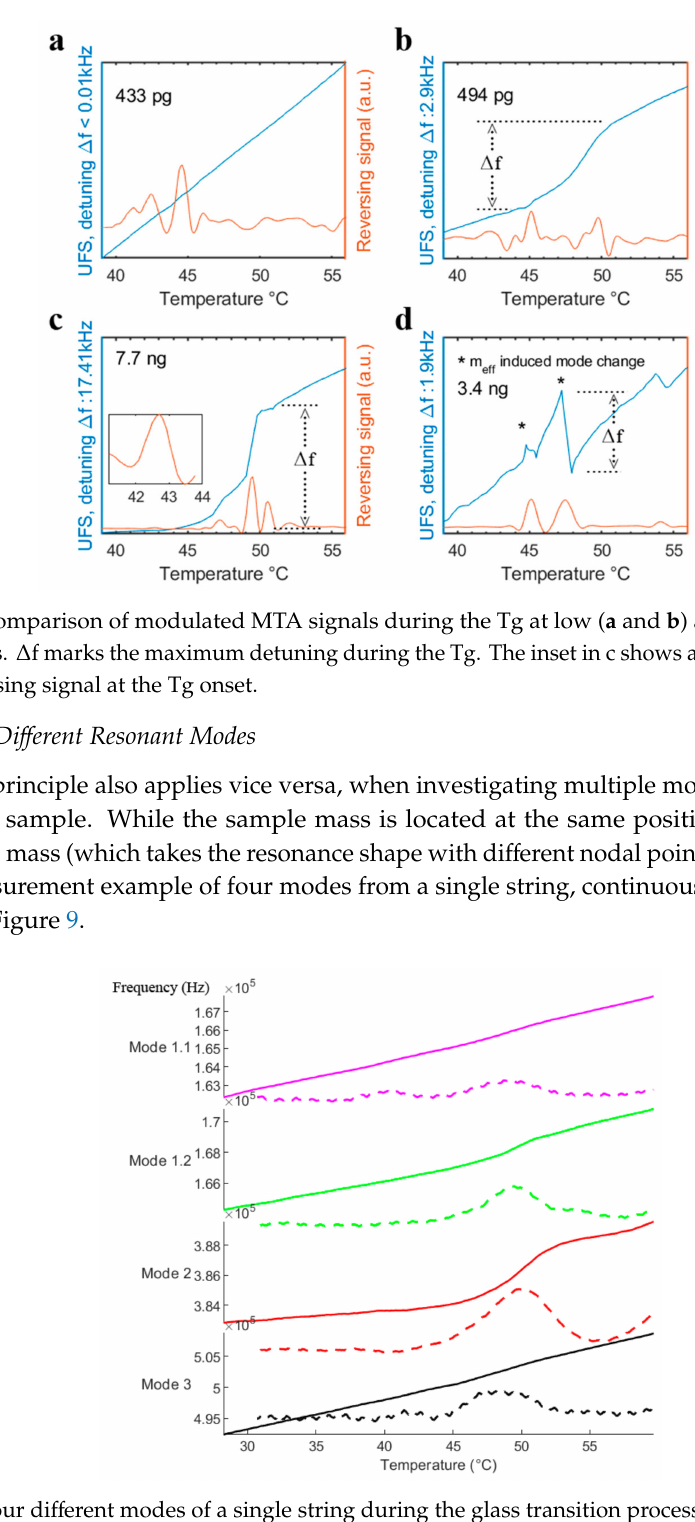
Figure 9. Four di ff erent modes of a single string during the glass transition process. The dashed lines represent the respective first derivative of the tracked